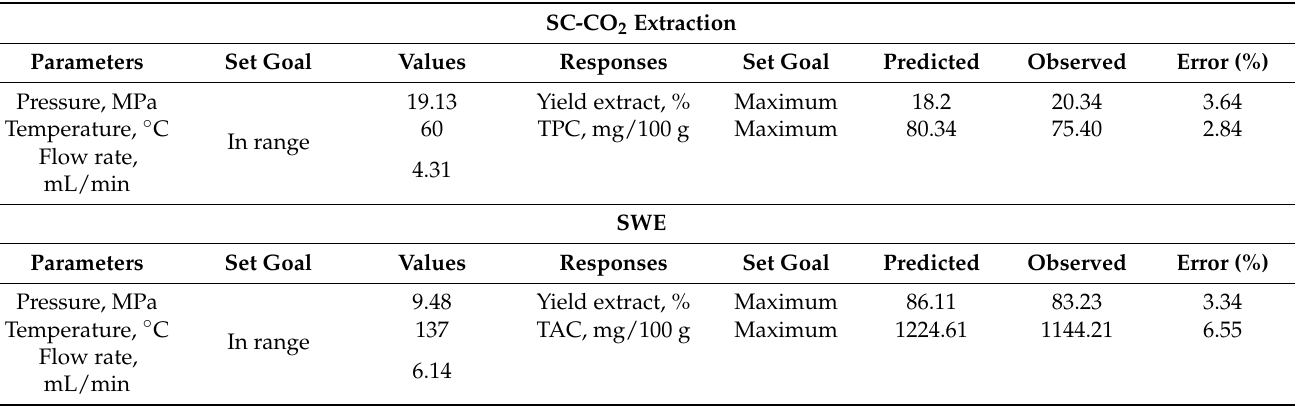
Table 4. The multiple responses optimization for combination ScCO 2 extraction and